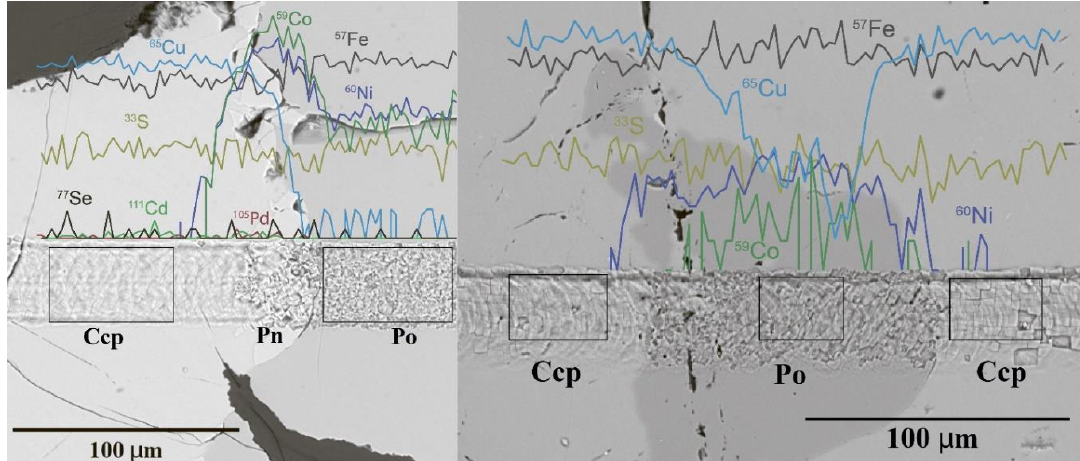
Figure 4. An example of two representative laser ablation lines on sulfide minerals. LA-ICPMS elemental spectra are shown by different colors. The LA-ICPMS data are superimposed on BSE images taken after the laser ablation analyses. Ccp — chalcopyrite, Po — pyrrhotite, Pn — pentlandite.